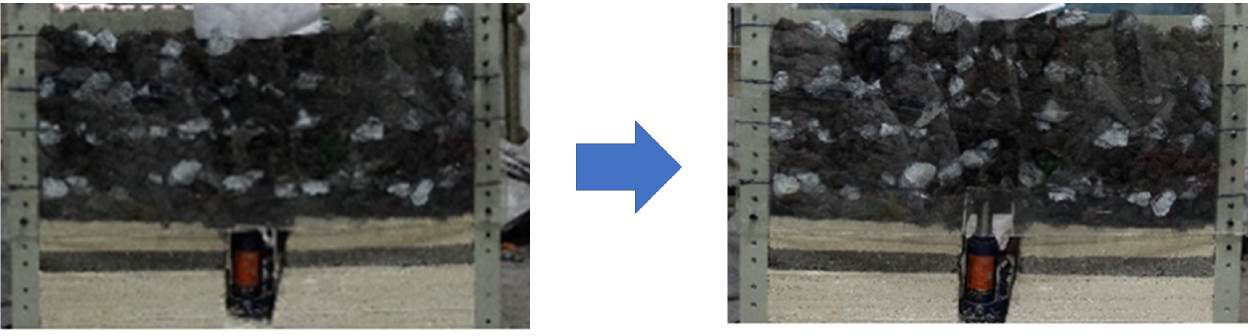
Figure 3. Particle expansion